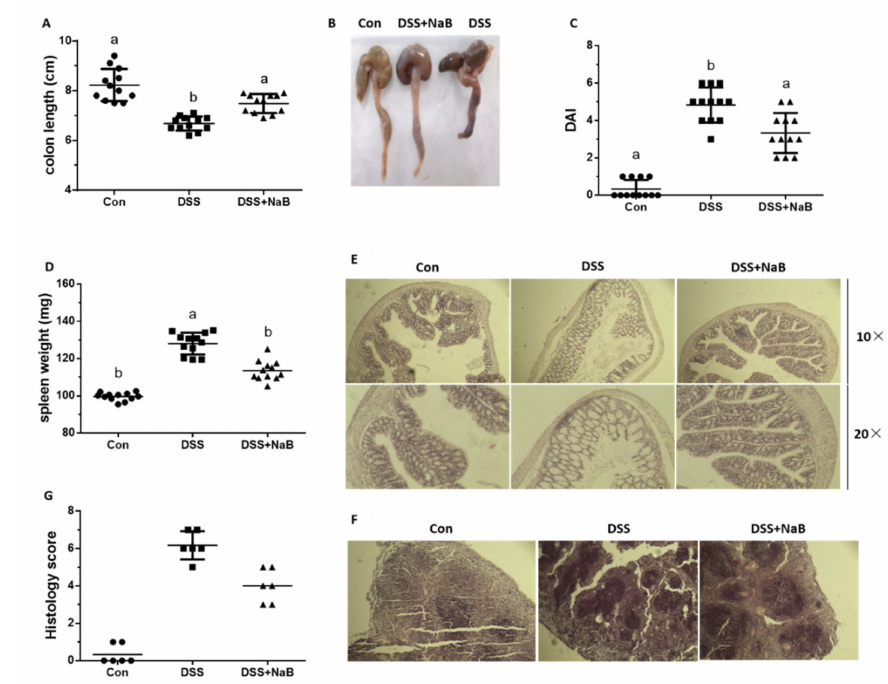
Figure 1. Oral NaB alleviates dextran sulfate sodium (DSS)-treated mouse colitis: ( A, B ) mouse colon length and morphology ( n = 8 per group), ( C ) DAI ( n = 12 per group), ( D ) spleen weight (n = 12 per group), ( E, F ) histological examination of colon tissues, and the spleen ( n = 6 per group) with histological evaluation (H&E) staining (magnification of 10 × , 20 × ), ( G ) histological score ( n = 6 per group). Con, control treatment; DSS, DSS treatment under the control treatment conditions; NaB + DSS, dietary addition of NaB followed by DSS treatment. Data are shown as the mean ± standard deviation (SD), and values with di ff erent letters show significant di ff erences ( p <